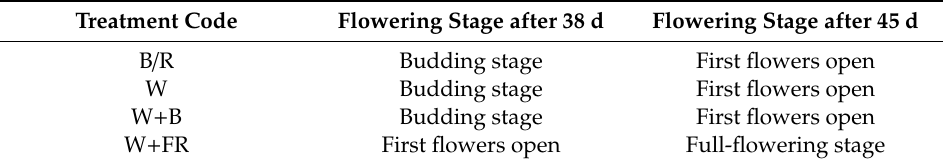
Table 2. Flowering state at the time of harvest for all four light treatments. Budding stage = no flower open, First flowers open = < 1% of flowers open, Full ‐ flowering stage = more than 2/3 of flowers open. Treatment Code Flowering Stage after 38 d Flowering Stage after 45 d B/R Budding stage First flowers open W Budding stage First flowers open W+B Budding stage First flowers open W+FR First flowers open Full ‐ flowering stage